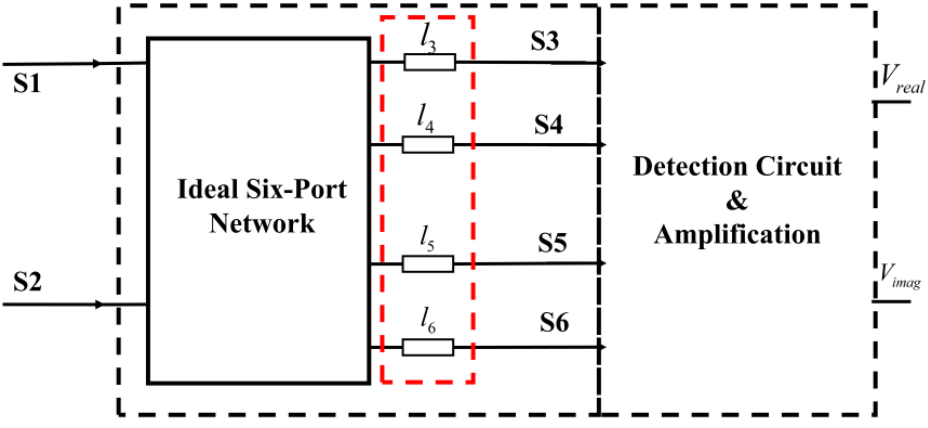
Figure 5. The schematic diagram of transmission line between six-port network and detector.